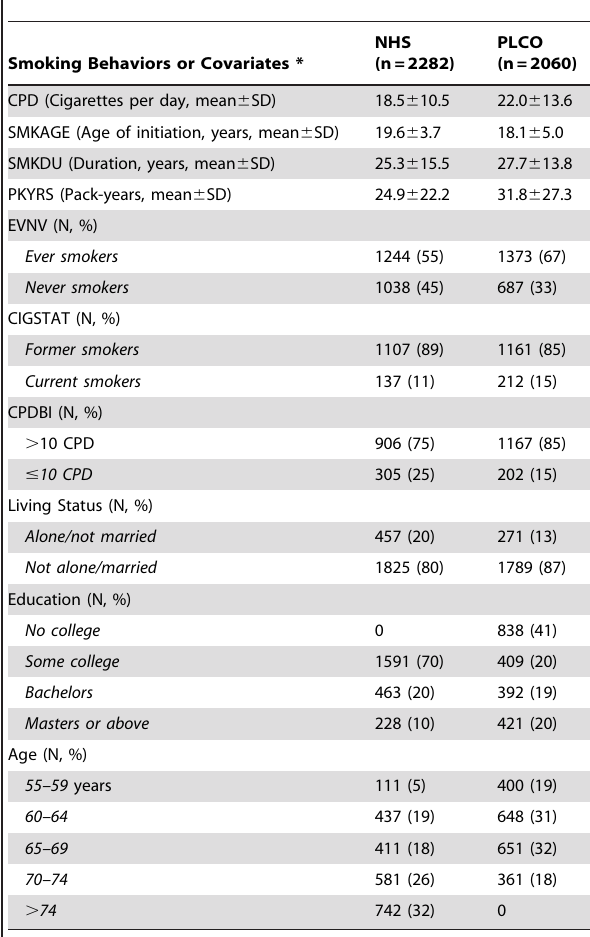
covariates in NHS and PLCO CGEMS